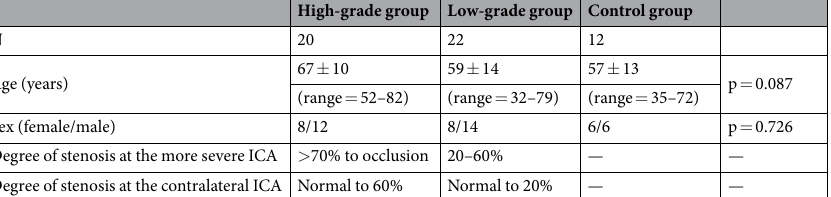
Table 1. Subject grouping and demographics. Age is expressed as mean ± standard deviation. Between group comparison: Kruskal-Wallis test for Age and Fisher’s exact test for